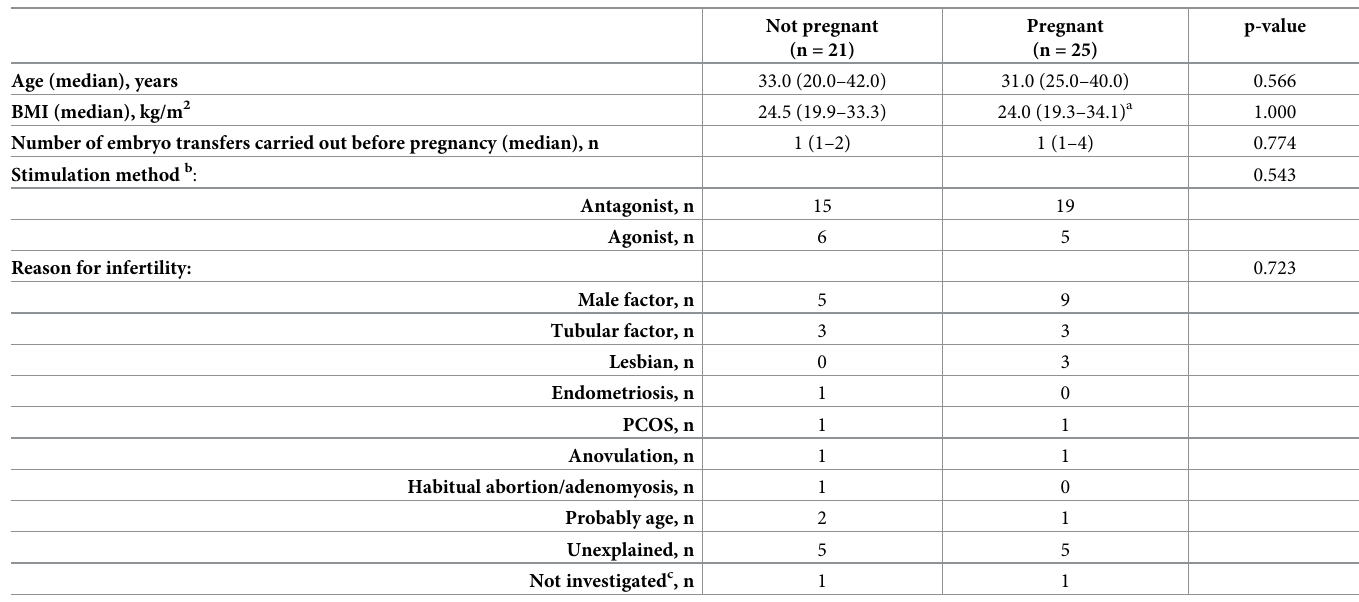
Table 3. Demographic data of women becoming and not becoming